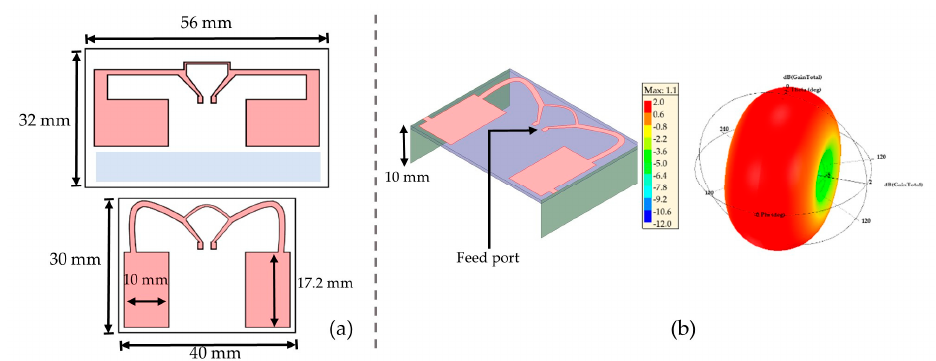
Figure 6. Designed antennas on HFSS: ( a ) The first miniaturized antenna and the second miniaturized antenna named A2: 3D FDA; ( b ) 3D polar plot of the radiation pattern of A2 antenna at the resonant frequency (HFSS results).